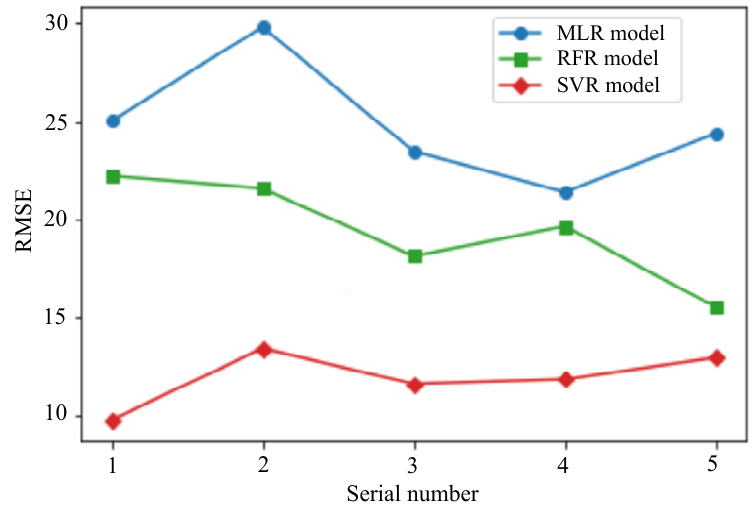
Figure 9. Comparison diagram of RMSE value of each model.